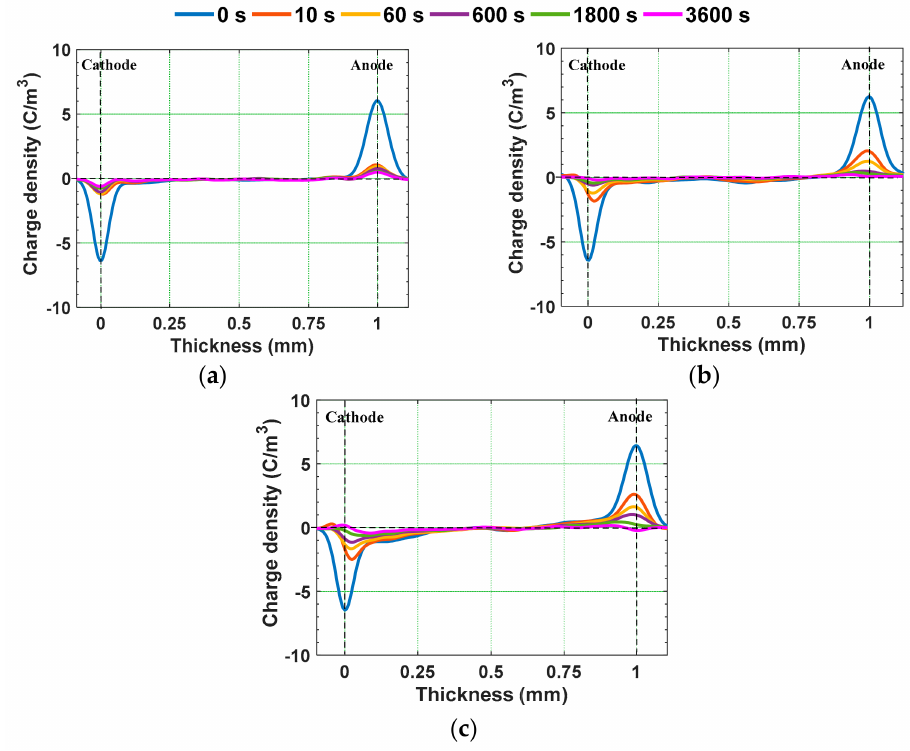
Figure 15. Space charge profiles during depoling in ( a ) unaged, ( b ) water aged sample at RT, and ( c ) water aged sample at 90 ◦ C